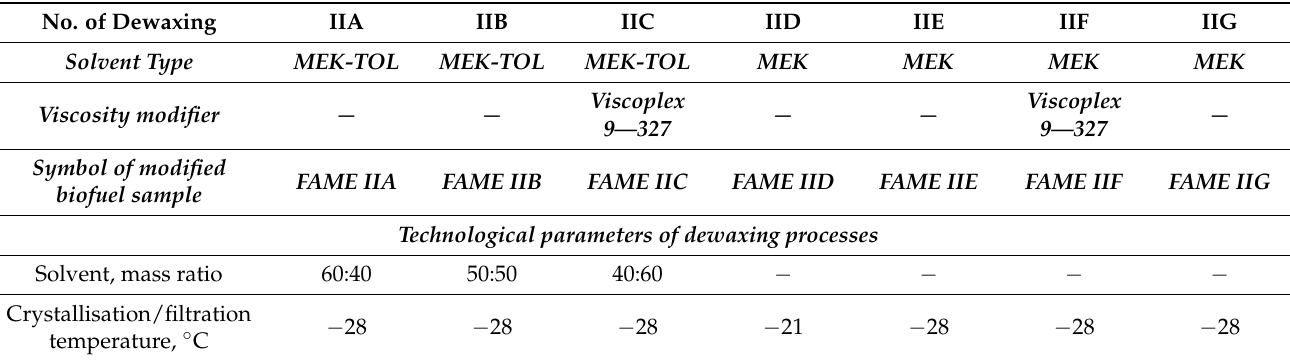
Table 3. Technological parameters and the mass balance of carried out tests, and properties of modified biofuels, when the FAME II was used as a raw